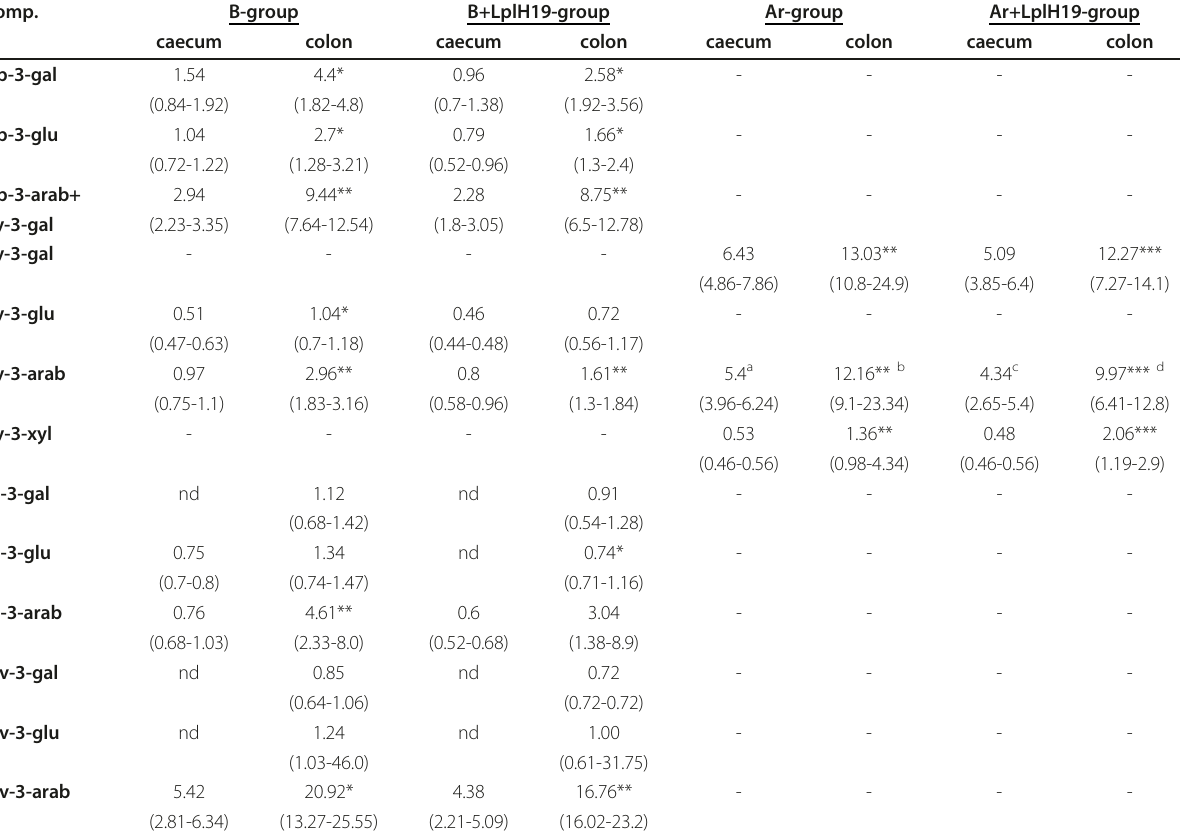
Table 1 Concentrations ( μ g/g) of anthocyanins in caecum and colon of mice administrated billberry (B) or chokeberry (Ar) alone or supplemented with strain L. plantarum HEAL19 (LplH19)